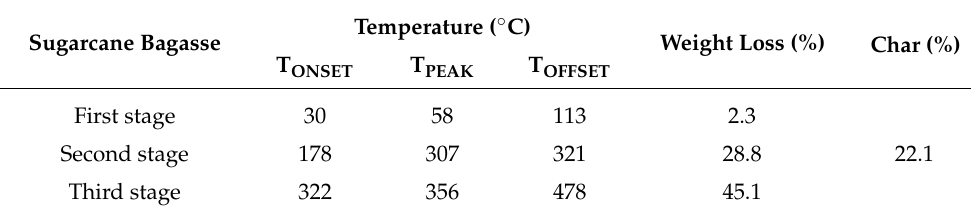
Table 1. Results from thermal degradation of sugarcane bagasse in N 2 atmosphere and heating rate of 10 ◦ C min − 1